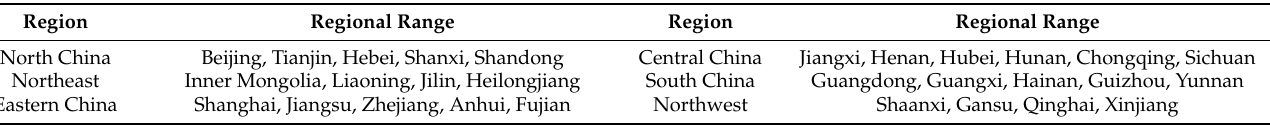
Table 4. Scope of China’s six regional power grids.